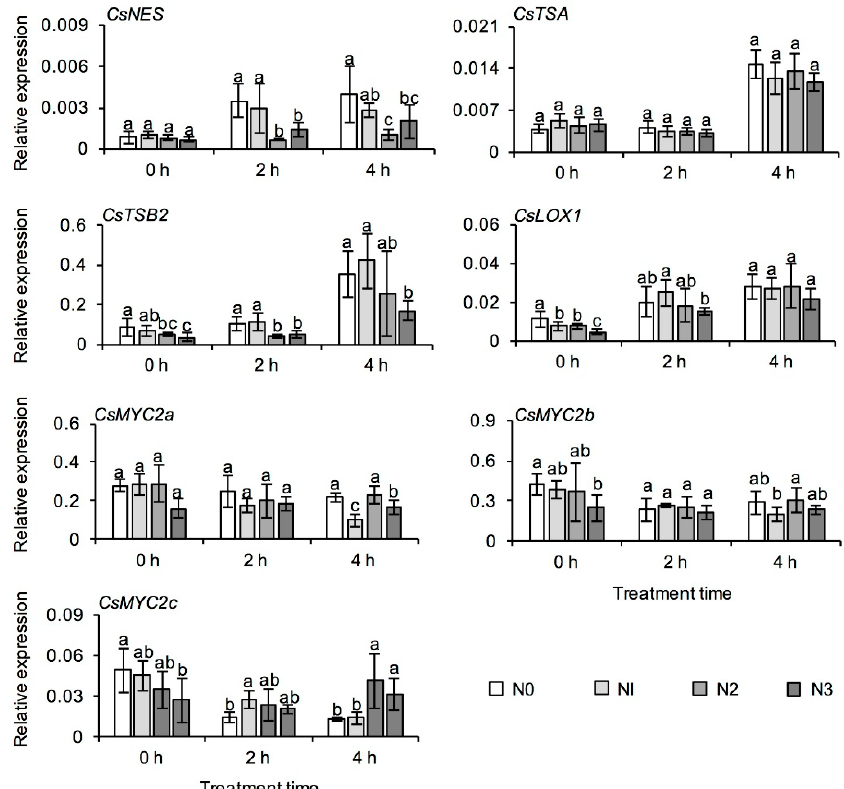
Figure 7. Effect of long-term nitrogen application on the expression of genes involved in aroma compounds formation in the withering stage of autumn tea. NES : (E)-nerolidol synthase ; TSB : tryptophan synthase β -subunit ; TSA : tryptophan synthase α -subunit ; LOX : lipoxygenase ; MYC : myelocytomatosis protein . The nitrogen application treatments indicate N0: 0 N kg/hm 2 ; N1: 112.5 N kg/hm 2 ; N2: 225 N kg/hm 2 ; N3: 450 N kg/hm 2 , respectively. Values followed by different letters (a–c) mean significant at the 5% level at the same treatment time among different treatments.